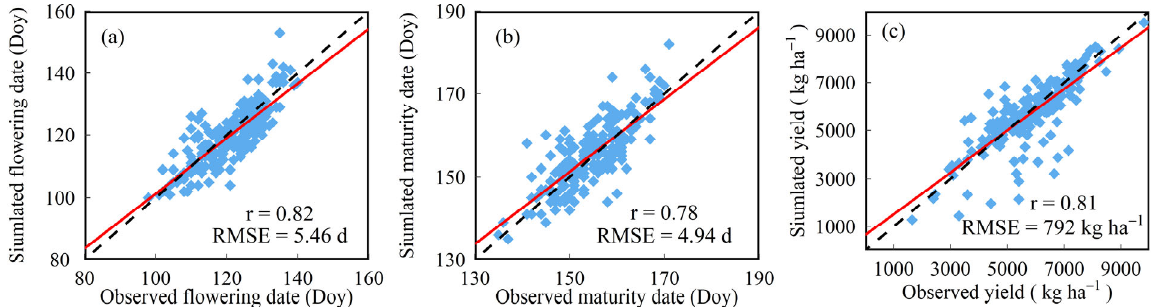
Figure 3. Comparison of observed and APSIM-simulated values of the flowering date ( a ), maturity date ( b ), and yield ( c ) from 2000 to 2010 at the 20 sites across the North China Plain. Red lines are the linear regression fit. Dashed lines represent the 1:1 lines.